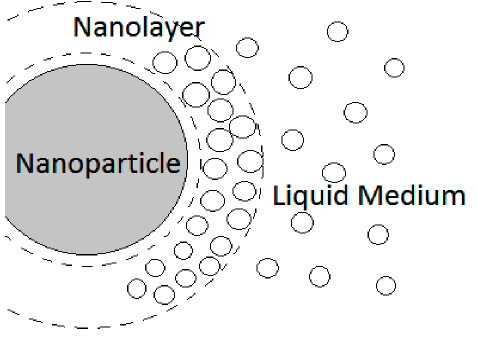
Figure 28. An illustration showing the formed interfacial nanolayer in between the nanoparticle and the base fluid. The nanoparticle is in grey, with the liquid medium molecules being depicted as white circles. The boundaries of the nanolayer are depicted as dashed lines around the nanoparticle.